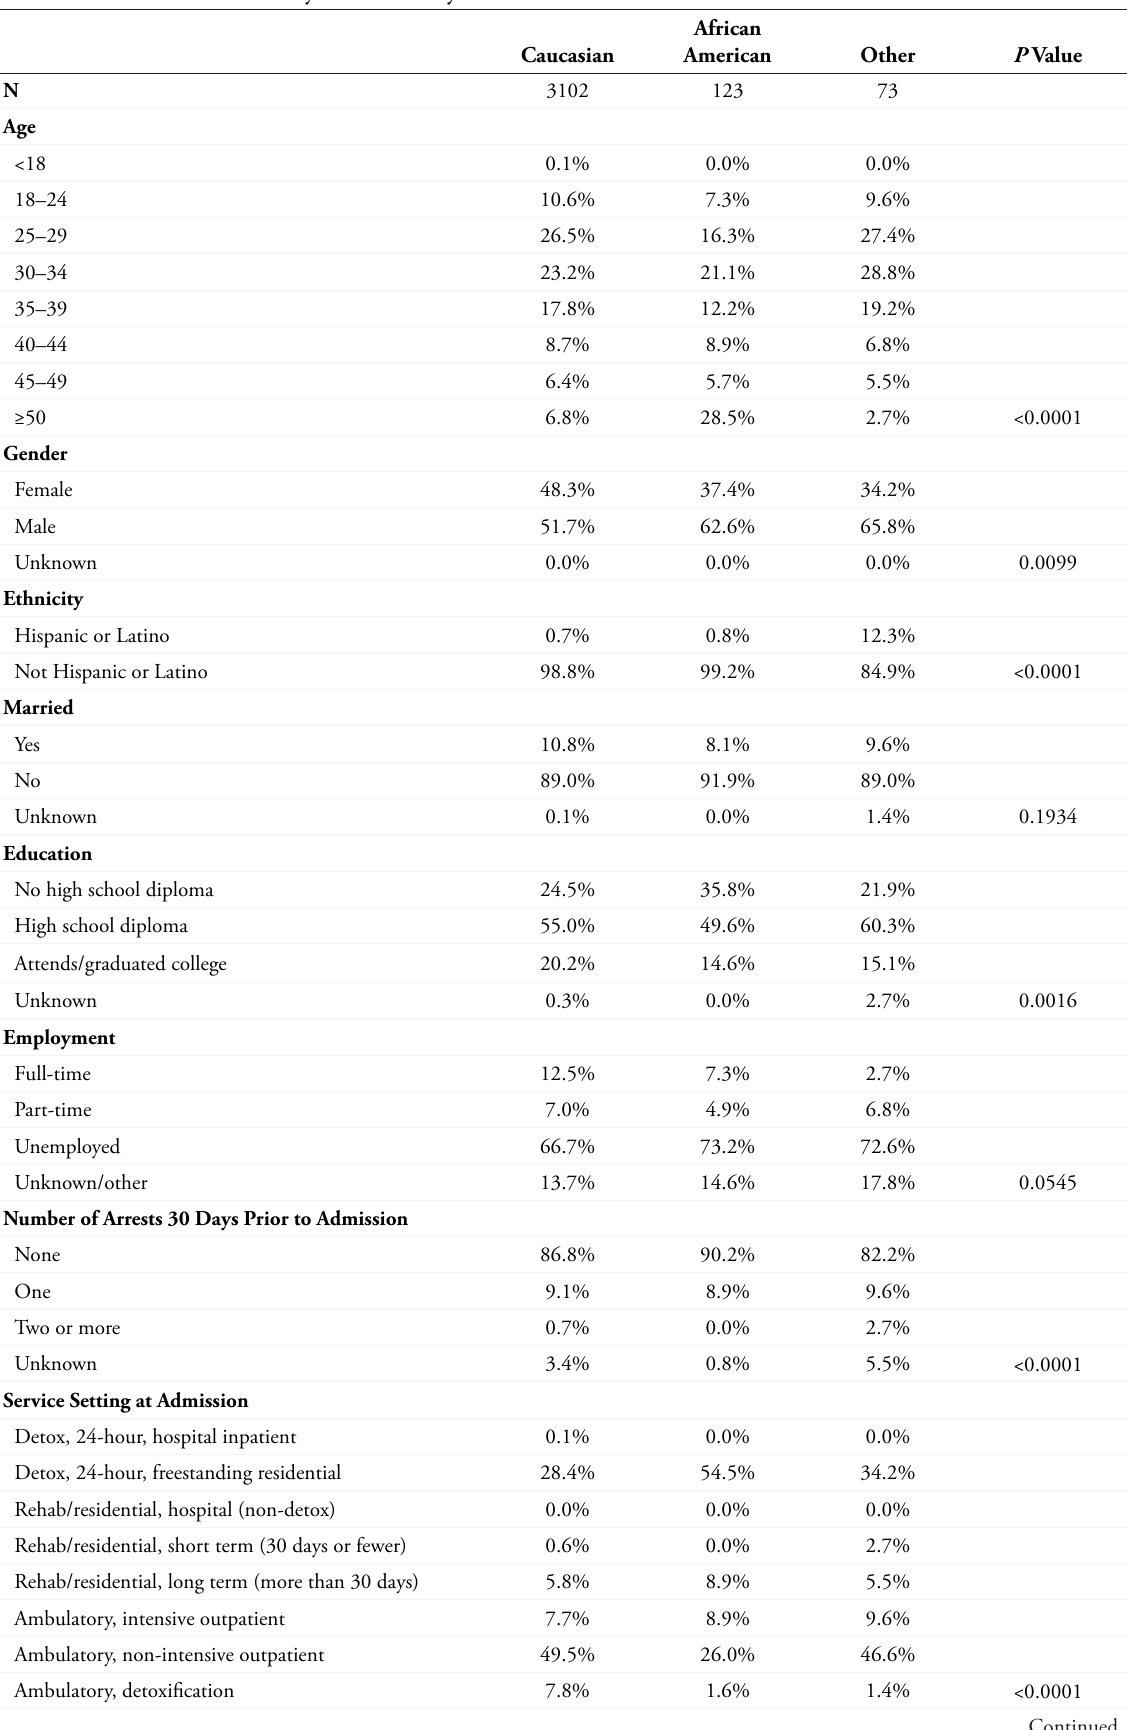
African Caucasian